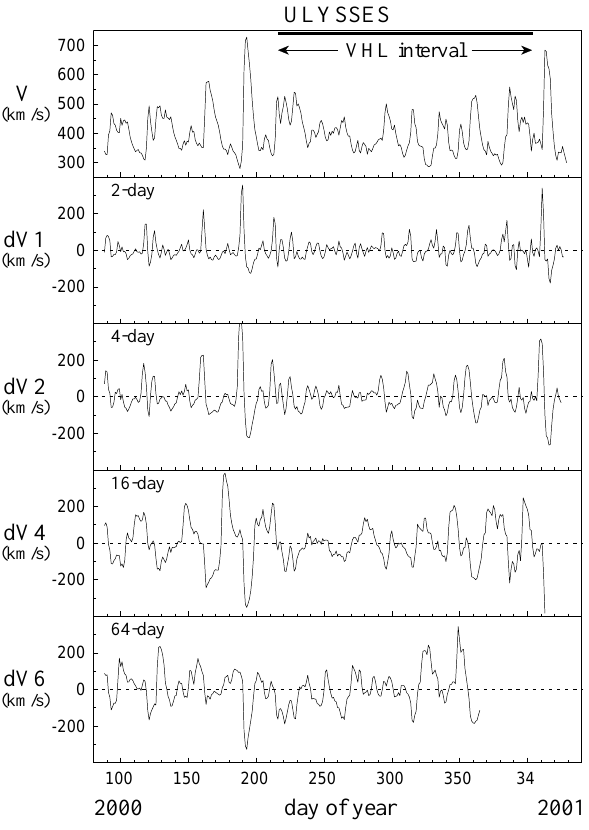
Fig. 3. From top to bottom: solar wind velocity ˇ and velocity dif- ferences dV 1, dV 2, dV 4, and dV 6 (at time lags of 2, 4, 16, and 64 days, respectively) versus time for the analysed Ulysses data. A bar on top indicates the VHL (Very-High-Latitude) interval.